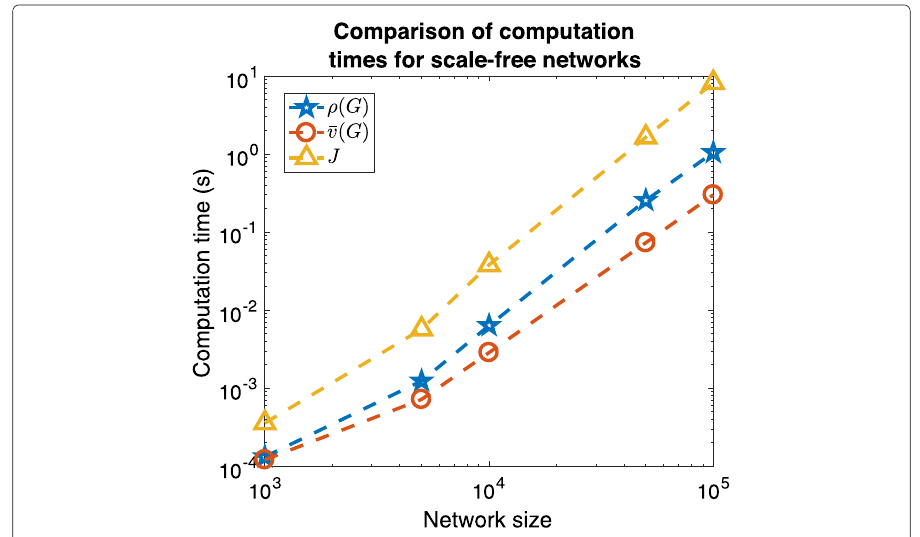
Fig. 3 The average computation times of degree variance normalisations ¯ v , J and ρ of scale-free networks of size 5,000, 10,000, 50,000 and 100,000. Both axes are on log scales. The closed form expression of ¯ v clearly outperforms J which requires construction of a quasi-star graph in the computation. It also outperforms ρ which employs the construction of the graph Laplacian in its computation